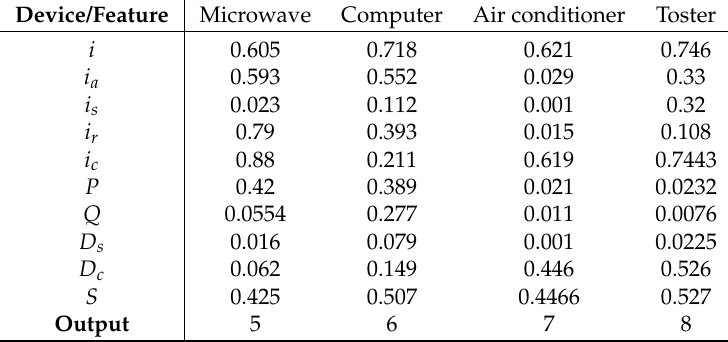
Table 2. CPC features for the chosen tested Devices 5–8.